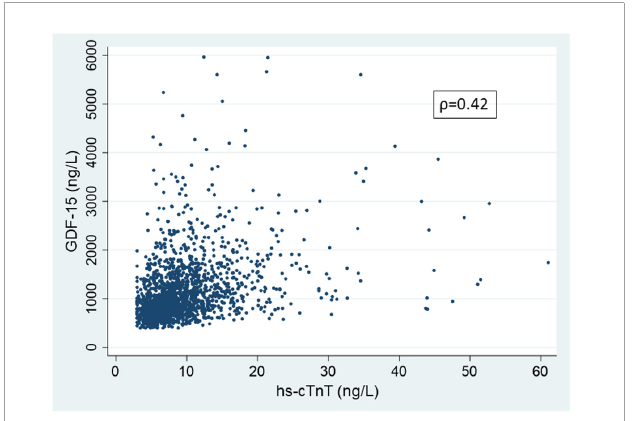
FIGURE2 Scatter plot showing the association of growth differentiation factor-15 (GDF-15) and high sensitivity cardiac troponin T (hs-cTnT) in participant undergoing cardiac magnetic resonance and receiving gadolinium at MESA exam 5 (n = 1737). Correlation calculated on entire data; for clarity in presentation, hs-cTnT values greater than 75 ng/L (99.8 percentile) and GDF-15 values greater than 6000 ng/L (99.7 percentile) are not